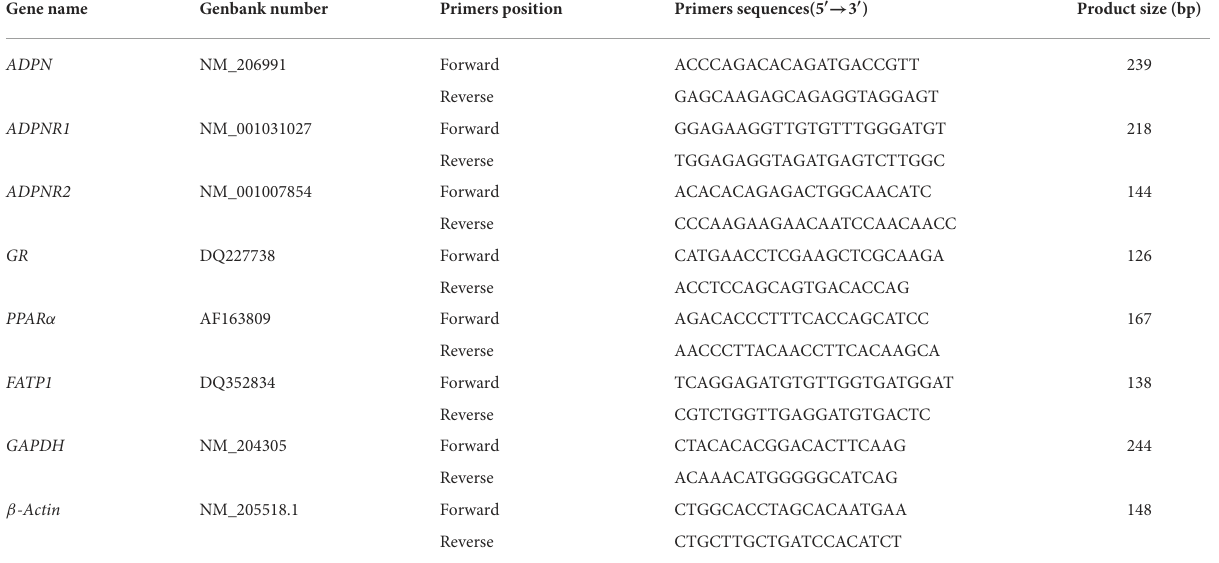
TABLE 2 Gene-specific primer of related